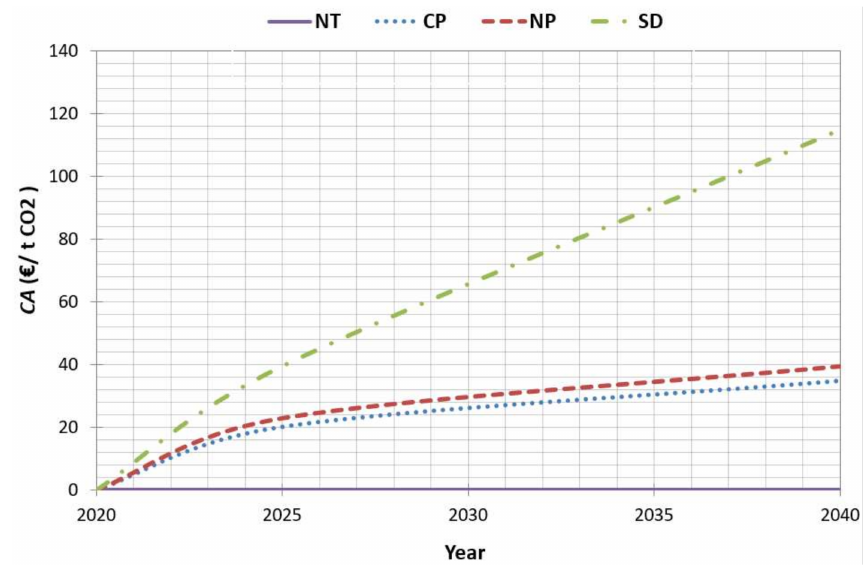
Figure 6. Carbon allowance